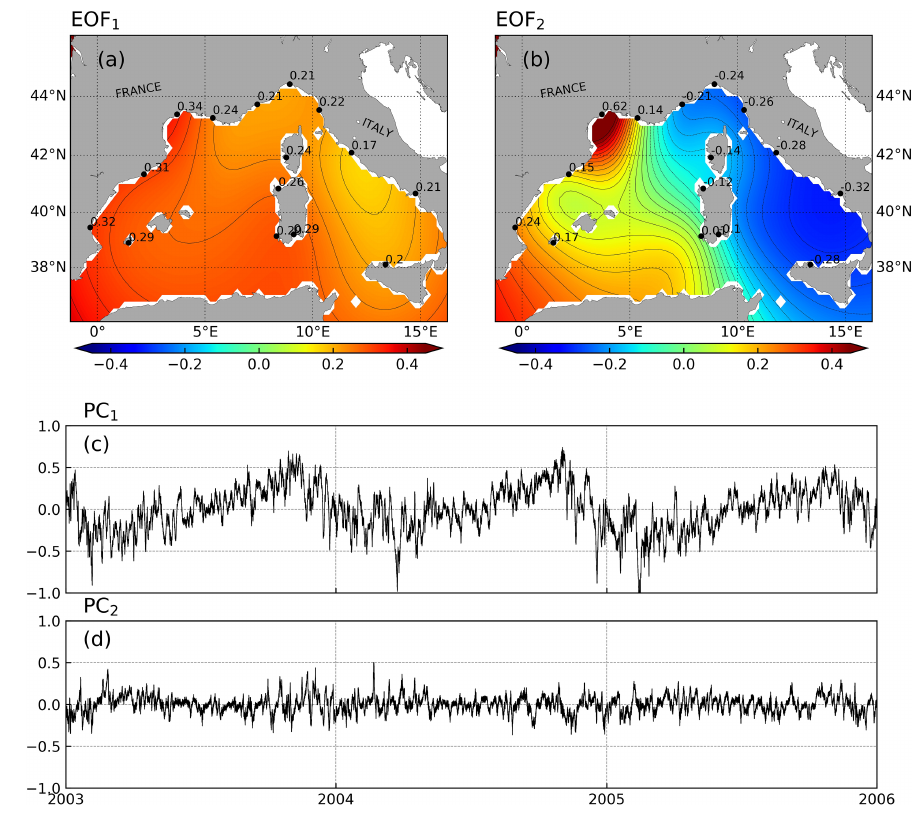
Figure 4. ( a ) The first EOFs of TGs sea level variability across the west Mediterranean Sea and ( c ) respond temporal amplitude. ( b ) The second EOFs of TGs sea level variability across the west Mediterranean Sea and ( d ) respond temporal amplitude. They accounted for 67.9% and 9.9% of non-tidal and non-atmospheric pressure corrected sea level variance within the basin, respectively. Colors denote the value of EOF spatial pattern. The black dot represents the location of TG